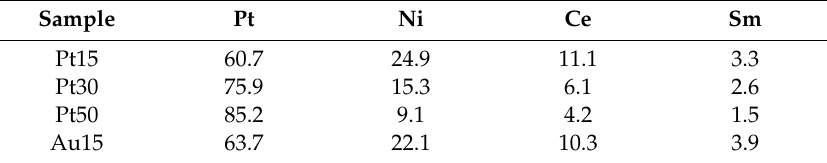
Table 1. The metal elements constituting the anodes analyzed by XRF (atomic %). Sample Pt